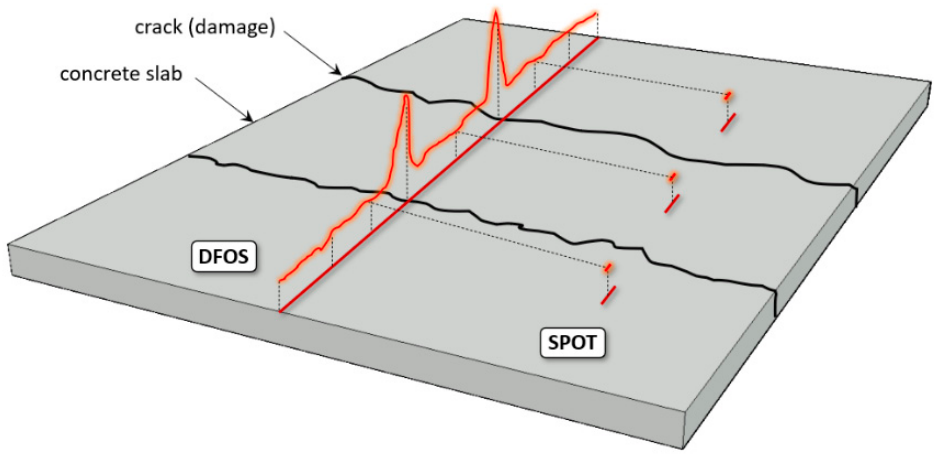
Figure 1. Comparison between capabilities of distributed fibre optic sensing DFOS and spot measure- ments in crack detection [8].